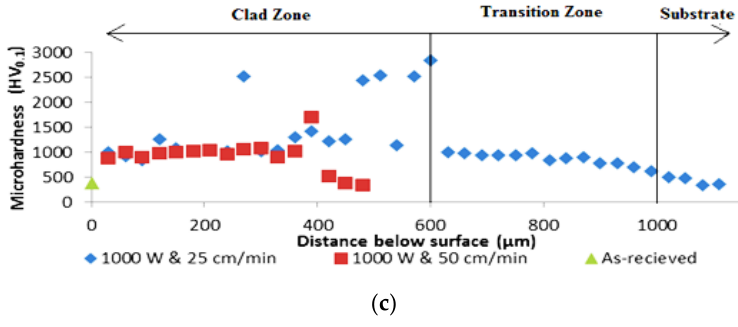
Figure 15. Microhardness profiles of samples processed at laser power of: ( a ) 600 W; ( b ) 800 W; and ( c ) 1000 W, for the two corresponding scanning speeds.